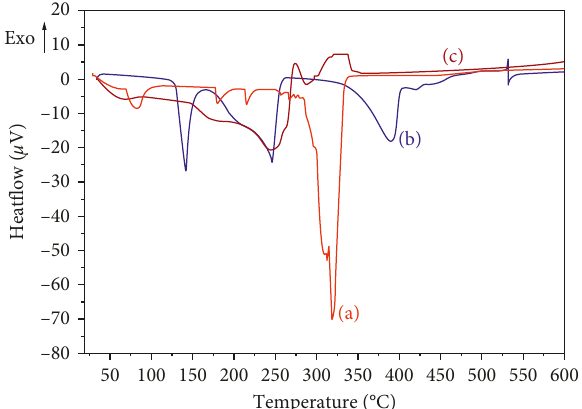
Figure 3: DSC of (a) choline chloride, (b) urea, and (c) choline chloride:urea (1:1).